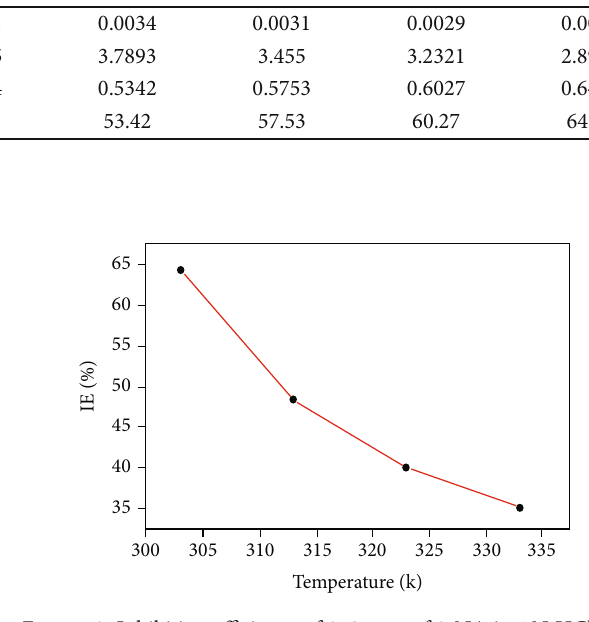
Table 1: Corrosion rate (mm/y) and inhibition e ffi ciency obtained from weight loss measurements for MS specimen in the absence and presence of 0-250 ppm concentrations of 3-NA inhibitor in acidic medium (1 N HCl). Conc. (ppm)